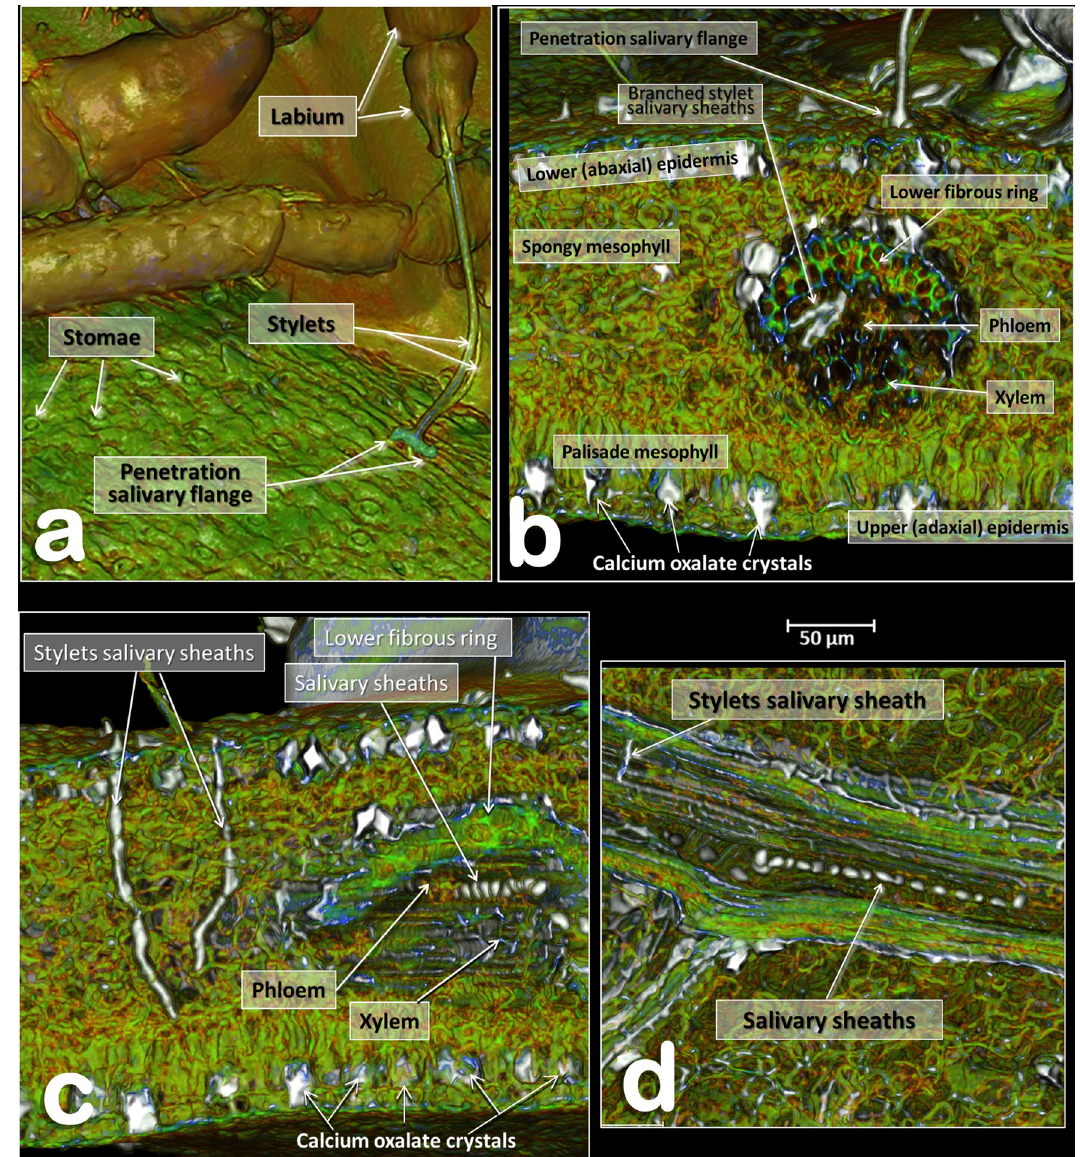
Figure 8. Volume-rendered images of details of an orange seedling tree leaf where a male Diaphorina citri was feeding on the abaxial surface of the leaf. Detail of the stylets and penetration point ( a ). Transverse cut of the leaf showing the penetration point of the stylets, different anatomical structures of the leaf and the tip of the stylets as branched stylet salivary sheaths inside the phloem ( b ). Transverse cut of the leaf showing abandoned stylets and salivary sheaths inside the phloem of a vein ( c ). Middle plane-cut, between the lower and upper surface of the leaf, at the level of the vein are shown both in a transversal cut ( c ) and in a longitudinal cut ( d The esophagus. The pharynx continues into the esophagus which, after a large loop, turn backwards, passing on and close to the ventral nerve cord (Figs. 11a,c, 12b and Supplementary Video S5), and then dilates slightly before connecting with the filter chamber (Fig. 15d,e and Supplementary Videos S5, S10). The midgut. The esophagus connects with a dilated afferent midgut (crop), runs backwards to the right and immediately down to form the medial descending midgut arm. After a ventral midgut loop the ascending mid- gut arm goes left and dorsally, and, after a fore dorsal midgut loop, a right fore midgut dorsal arm runs back- wards and down to a right descending dorsal middle arm; from here and after a right midgut middle loop, is the start of the right ascending midgut dorsal middle arm in which the 1st midgut appendage is inserted (located in a right-fore position); after this, the right hind midgut dorsal arm continues and joins the 2nd midgut appendage (located in a right-hind position); after this, the left hind midgut dorsal arm continues forwards (the 3rd midgut appendage connects to it and is located in a left-hind position immediately after the connection of the 2nd mid- gut appendage), and immediately turns down, forming a short left descending midgut dorsal arm which, after a